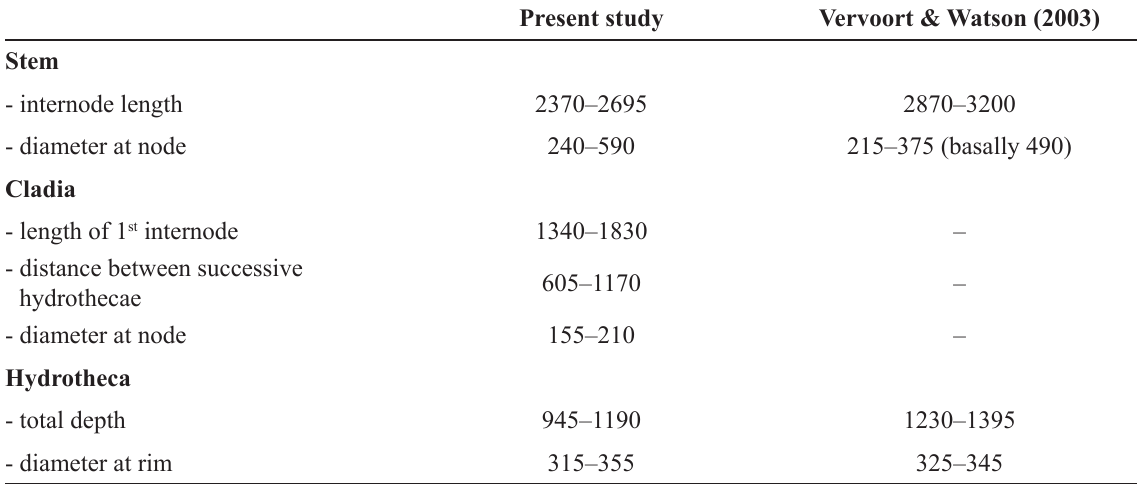
Table 2. Measurements of Billardia hyalina Vervoort & Watson, 2003, in